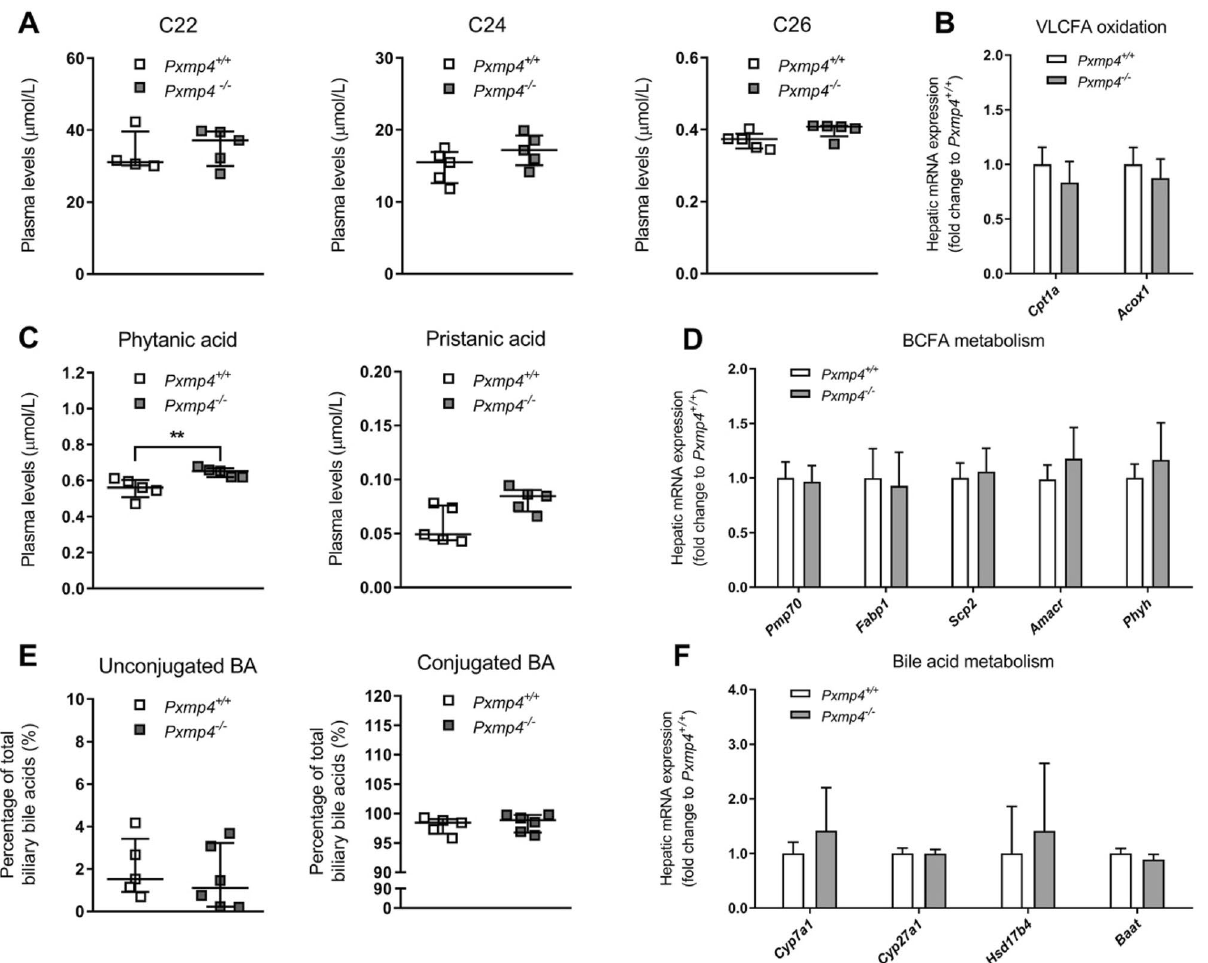
Figure 2. Effect of PXMP4 deficiency on peroxisome function under standard chow conditions. ( A ) Plasma levels of the VLCFAs docosanoic acid (C22), lignoceric acid (C24) and hexacosanoic acid (C26); ( B ) Hepatic expression of genes involved in VLCFA oxidation; ( C ) Plasma levels of the BCFAs phytanic and pristanic acid; ( D ) Hepatic expression of genes involved in metabolism of BCFAs phytanic and pristanic acid; ( E ) Biliary unconjugated and conjugated bile acid concentrations; ( F ) Hepatic expression of genes involved in bile acid metabolism in Pxmp4 −/− mice and wild type littermates (n = 5–6). Scatter plots represent individual data with a median ± IQR and statistical significance was tested by a Mann–Whitney test. Bar plots represent mean ± SD and significance was tested by the non-parametric one-way ANOVA (Kruskal–Wallis) test, followed by Mann– Whitney U